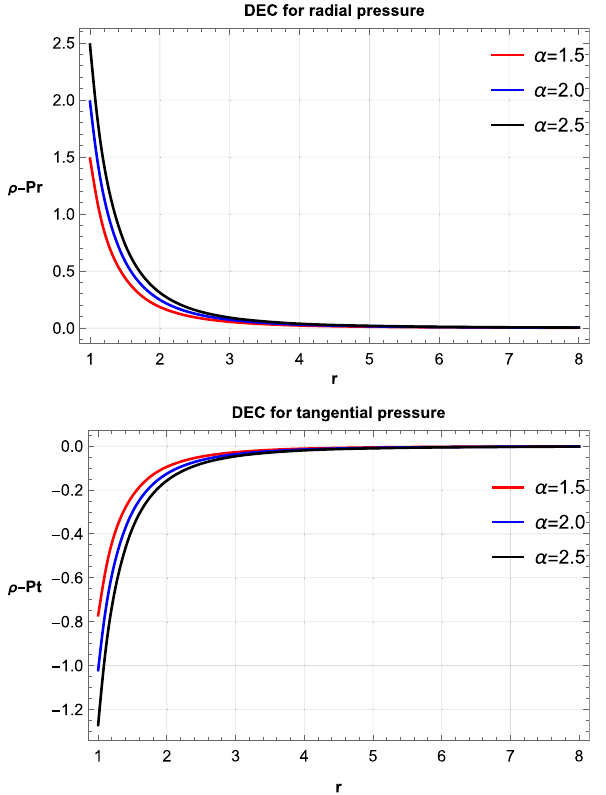
Fig. 5 Shape function and flare-out condition for the parallel cylinder with r 0 = 0 .